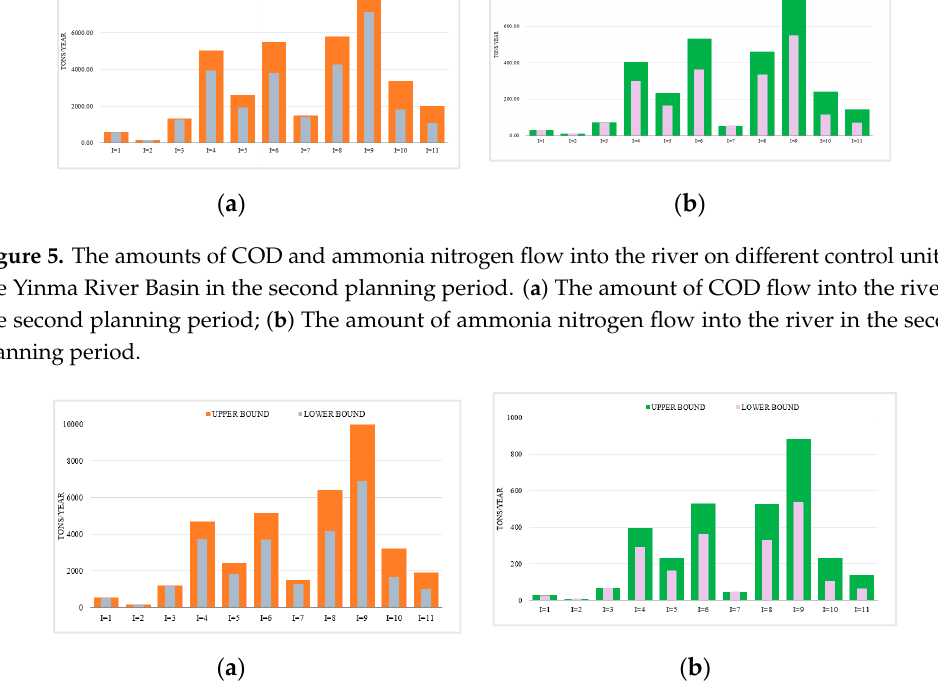
Figure 6. The amounts of COD and ammonia nitrogen flow into the river on different control units in the Yinma River Basin in the third planning period. ( a ) The amount of COD flow into the river in the third planning period; ( b ) The amount of ammonia nitrogen flow into the river in the third planning period.